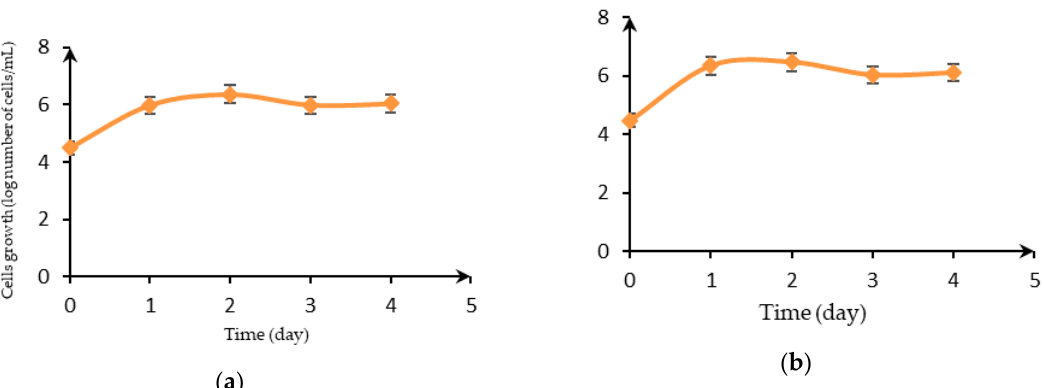
Figure 1. Growth curves of S. cerevisiae sahand 101 in the industrial medium in aerobic conditions ( a ) and in aerobic – anaerobic conditions ( b ).